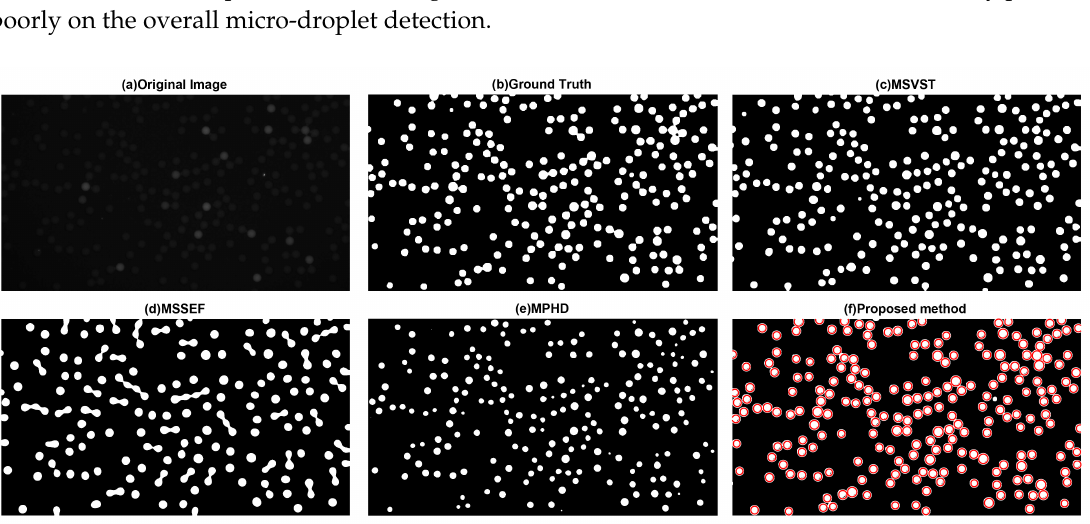
Figure 5. Comparative results of segmented binary maps of different methods: ( a ) Original image. ( b ) Ground truth. ( c ) Multiscale variance-stabilizing transform (MSVST). ( d ) Multiscale spot-enhancing filter method (MSSEF). ( e ) Maximum possible height-dome method (MPHD). ( f ) The proposed